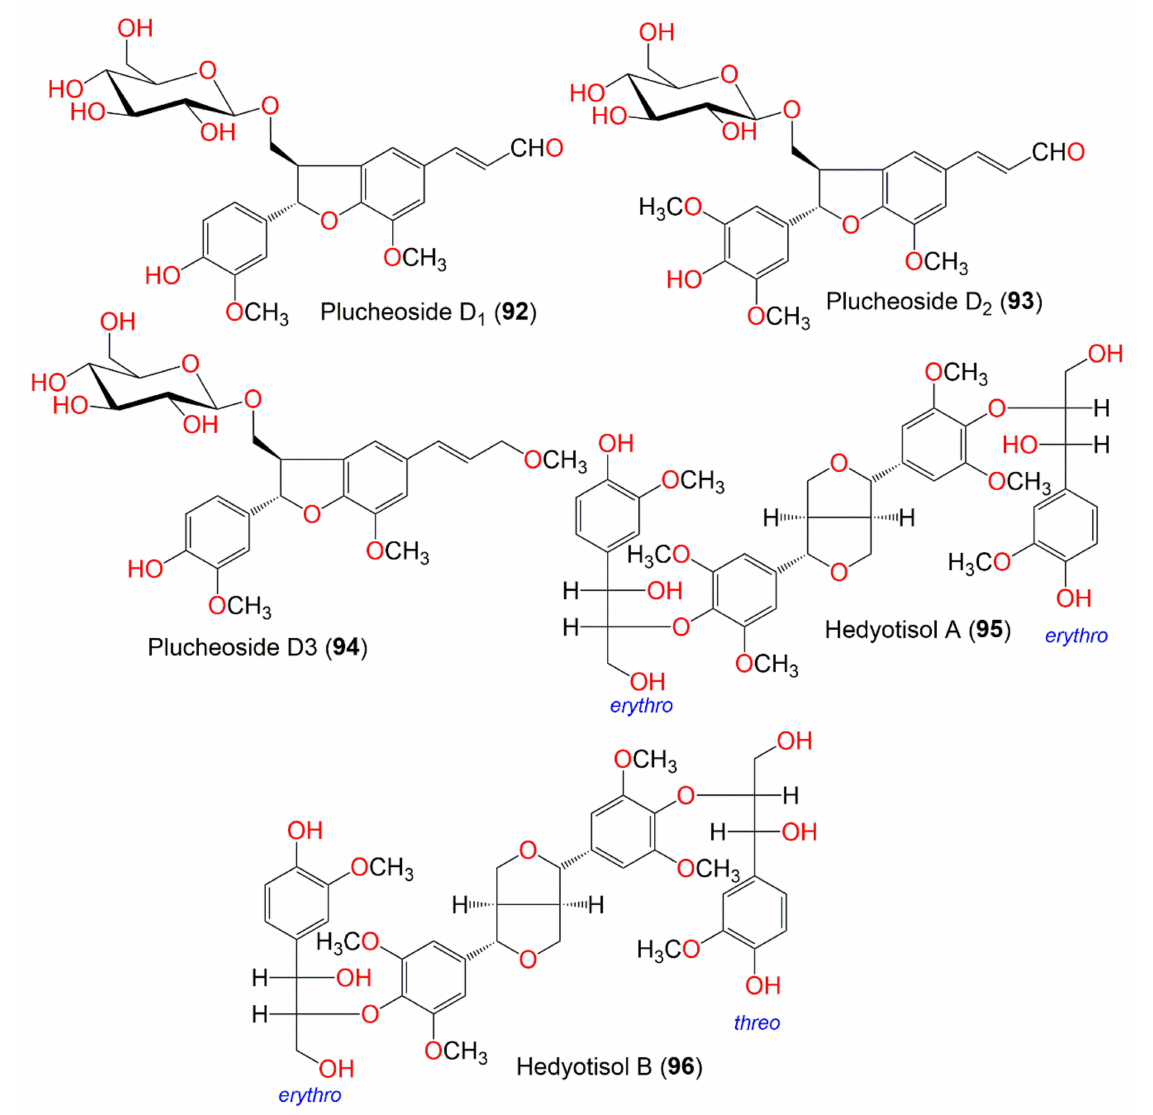
Figure 10. Structures of compounds 92 – 96